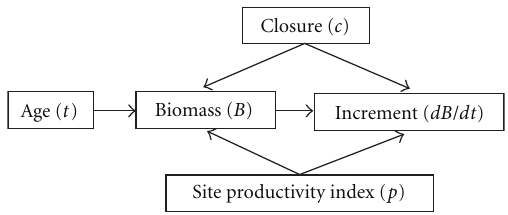
Figure 3: Directed acyclic graph showing which variables (arrow from) are used to predict other variables (arrow